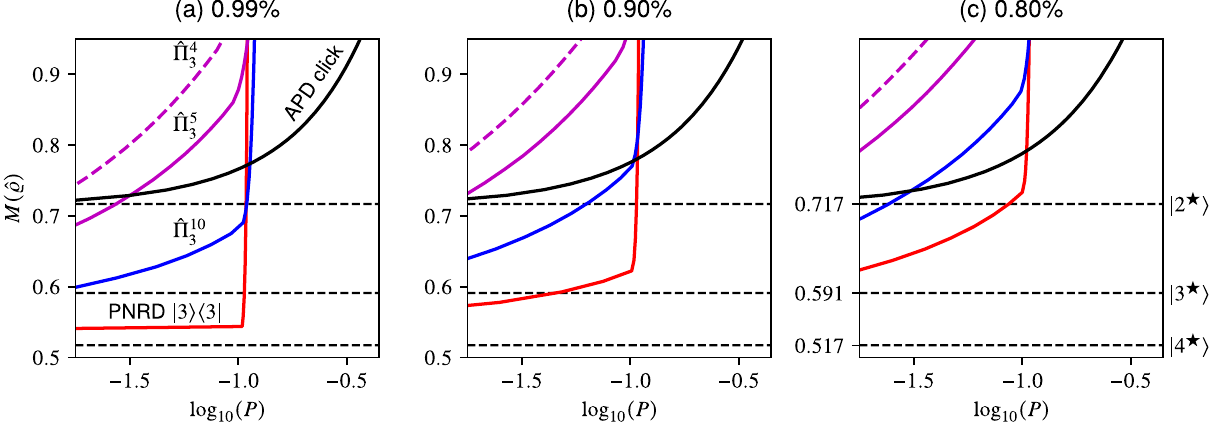
ρ) as a function of success probability. The variance is Figure 5. A comparison of attainable variance M ( ˆ normalized with respect to the minimal variance achievable by Gaussian states. We use the same vertical and horizontal axes in the plots to show the contrast between the almost ideal (a) and lossy (b, c) scenarios with 99% , 90% and 80% transmission efficiencies. Horizontal dashed lines are used to mark the optimal cubic state v ⋆ approximations (cid:31) (cid:30) (cid:31) 4 3 , dashed magenta), five ( (cid:31) 5 3 , magenta) and ten ( (cid:31) 10 3 , blue) detectors where three detectors (cid:31) ˆ ˆ ˆ 3 click. Overall, utilizing the PNRD (solid red) produces states with lowest non-linear variance, therefore | � producing comparatively better approximations of the cubic state. In both (b) and (c) a single APD